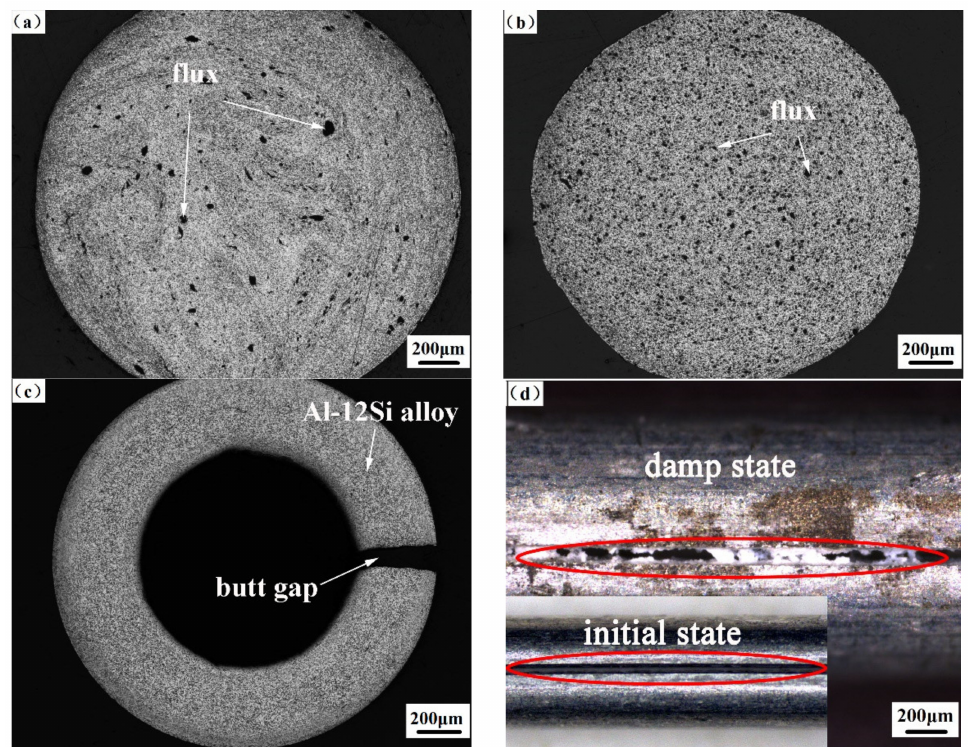
Figure 4. The cross-sectional distribution of different brazing filler metals and the changes in the gaps of the SFC brazing filler metal: ( a ) PM brazing filler metal; ( b ) SKA brazing filler metal; ( c ) SFC brazing filler metal; ( d ) Flux state at the butt gap of the SFC brazing filler